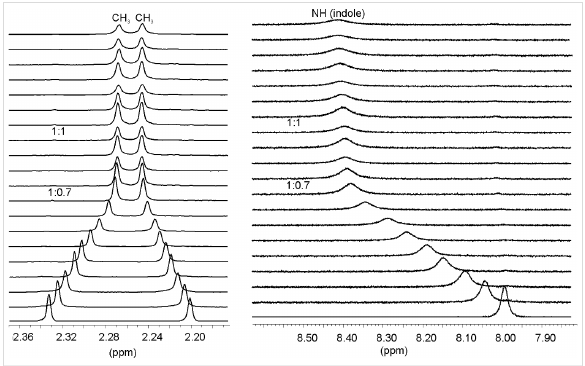
Figure 6: Partial 1 H NMR spectra (400 MHz, CDCl 3 ) of 5 after addi- tion of (from bottom to top) 0.00–1.63 equiv of β-maltoside 11 ([ 5 ] = 0.96 mM). Shown are chemical shifts of the pyridine CH 3 and indole NH signals of receptor 5